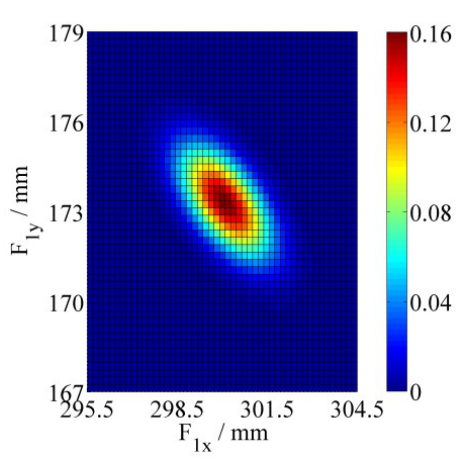
Figure 23. The fitting PDF